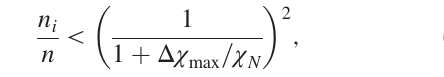
FIG. 2. Position of the minimum phase velocity z function of ~ n top